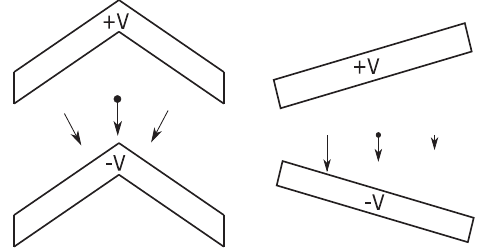
FIG. 2. Electrode cross sections in the transverse plane: The Dubna V shape (left) and the Sumitomo angled electrodes